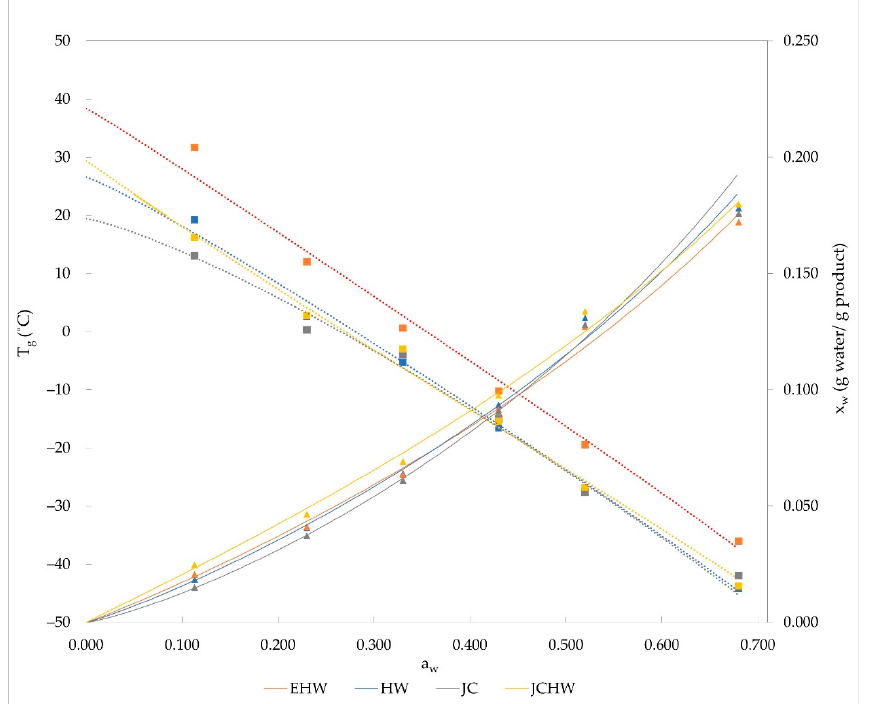
Figure 1. Temperature–water activity and water activity–water content relationship of different treatments. HW: hot water; EHW: extrusion + hot water; JC: jet cooker; JCHW: jet cooker + hot water. Experimental data (T g ν and x w ▲ ) and fitted models (Henderson and Gordon and Taylor models). Dashed line predicted with Equation (1); continuous line predicted with Equation (5). To keep the HW, EHW and JCHW powders in their glassy state at 20 °C, they must be stored in an atmosphere with moisture lower than CWA, and their water content should be lower than the CWC. In the case of HW, the maximum relative humidity of the